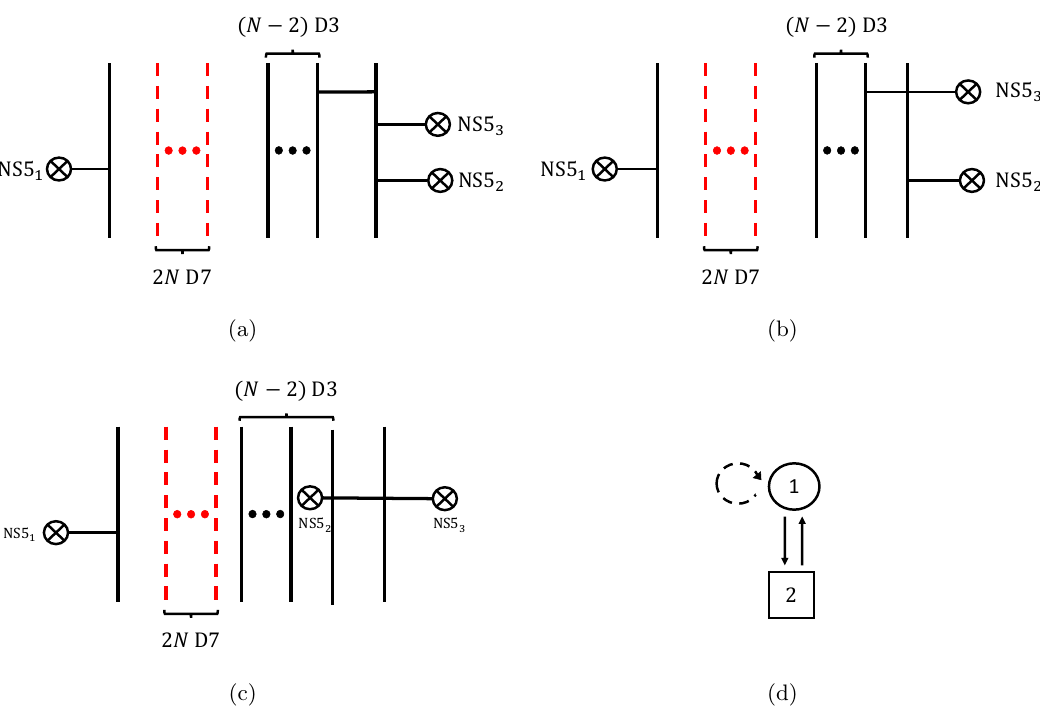
Figure 15 . (a) An introduction of a smooth monopole to (cid:12)gure 14. (b) We adjust the position of the D1-brane to realize the screening sector v = (cid:0) e 1 + e N (cid:0) 1 + e N . (c) The brane con(cid:12)guration that allows us to read o(cid:11) the SQM for the sector. (d) The corresponding quiver diagram. screening contribution in the sector v = (cid:0) e SQM is depicted in (cid:12)gure 15(d). The quiver theory has an FI parameter (cid:16) from the single U(1) gauge node. The FI parameter is related to the position of two of the three